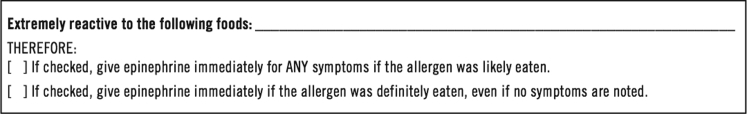
Extract from the Food Allergy Research & Education (FARE) emergency self-care plan.1